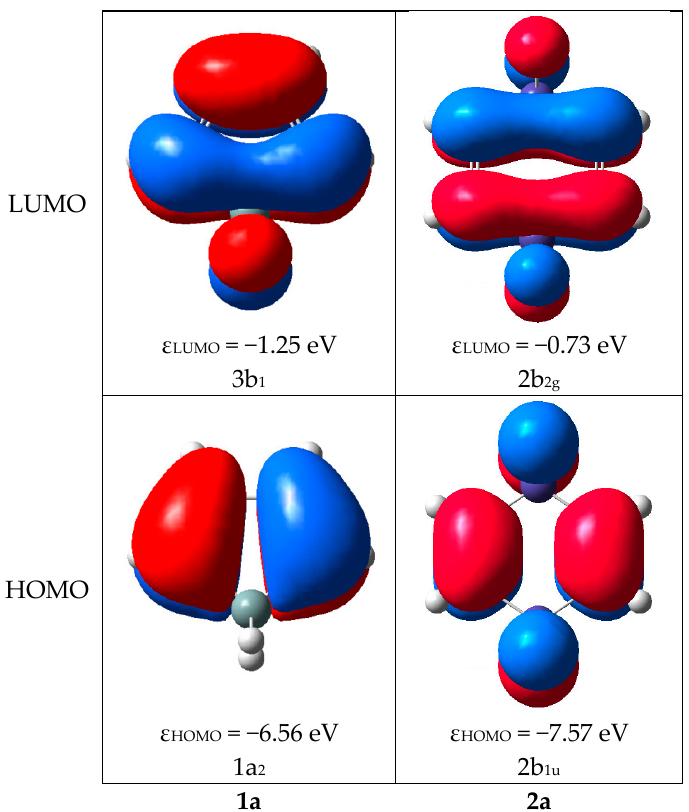
Figure 8. Plots of HOMO and LUMO of 1a and 2a , respectively, their orbital energies at PBE0/6-31G(d) level and their symmetry notations and orders.